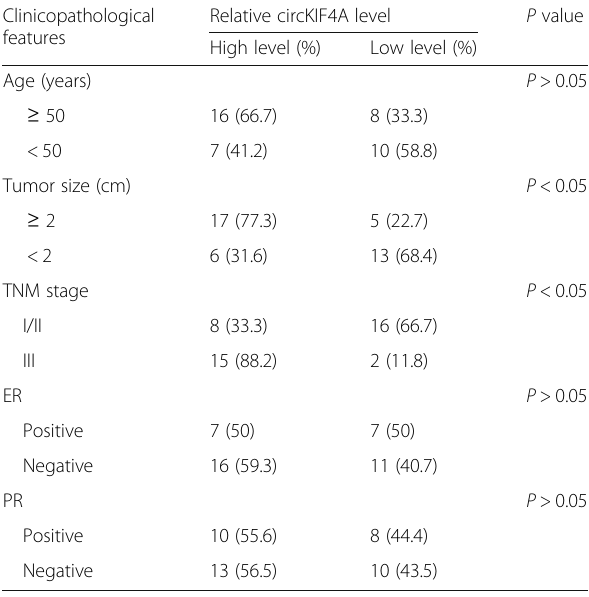
Table 1 Relationship between expression of circKIF4A and clinicopathological features of breast cancer patients Clinicopathological